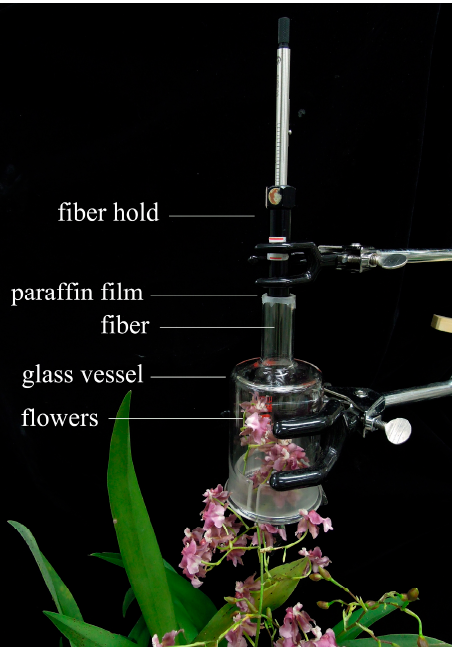
Figure 5. Diagram of enclosure system for collection of floral aroma from Onc. Rosy Sunset.